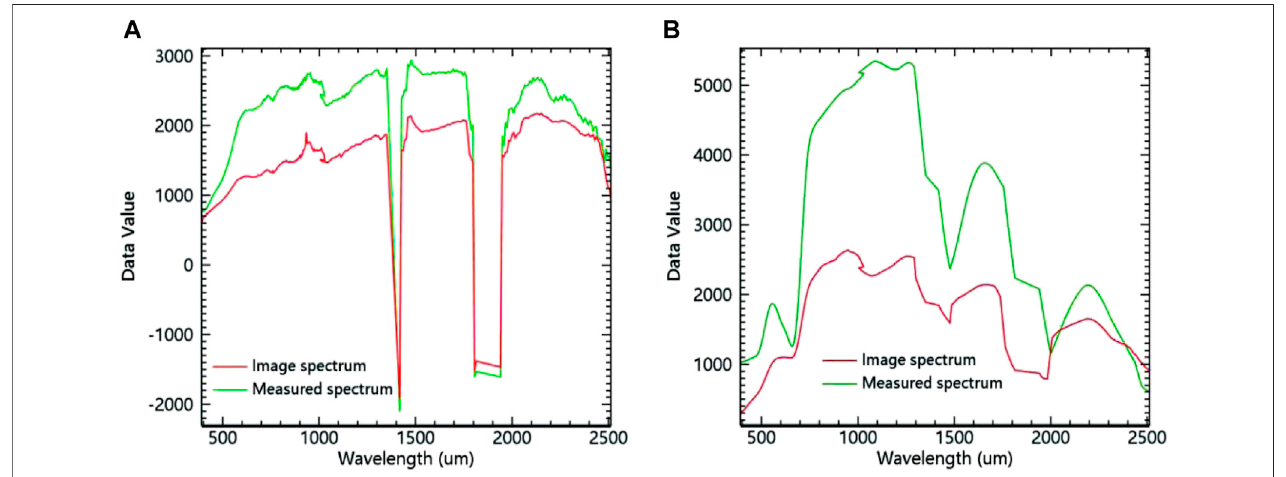
FIGURE 2 | Field measured spectra and image spectra of ground objects. (A) Badlands and (B) vegetation.